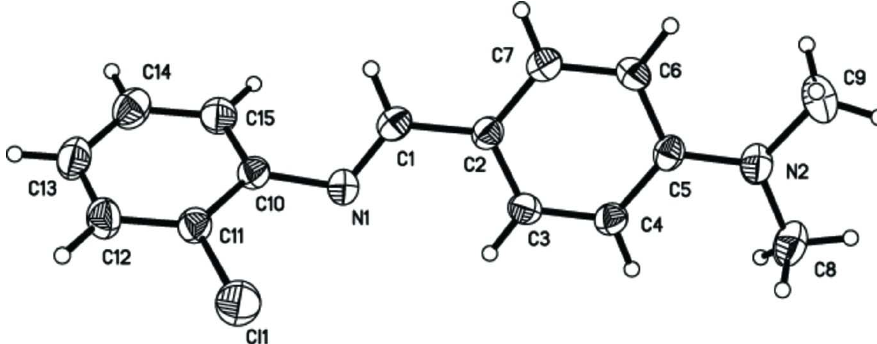
Figure 1 The molecular structure of (I), drawn with 30% probability